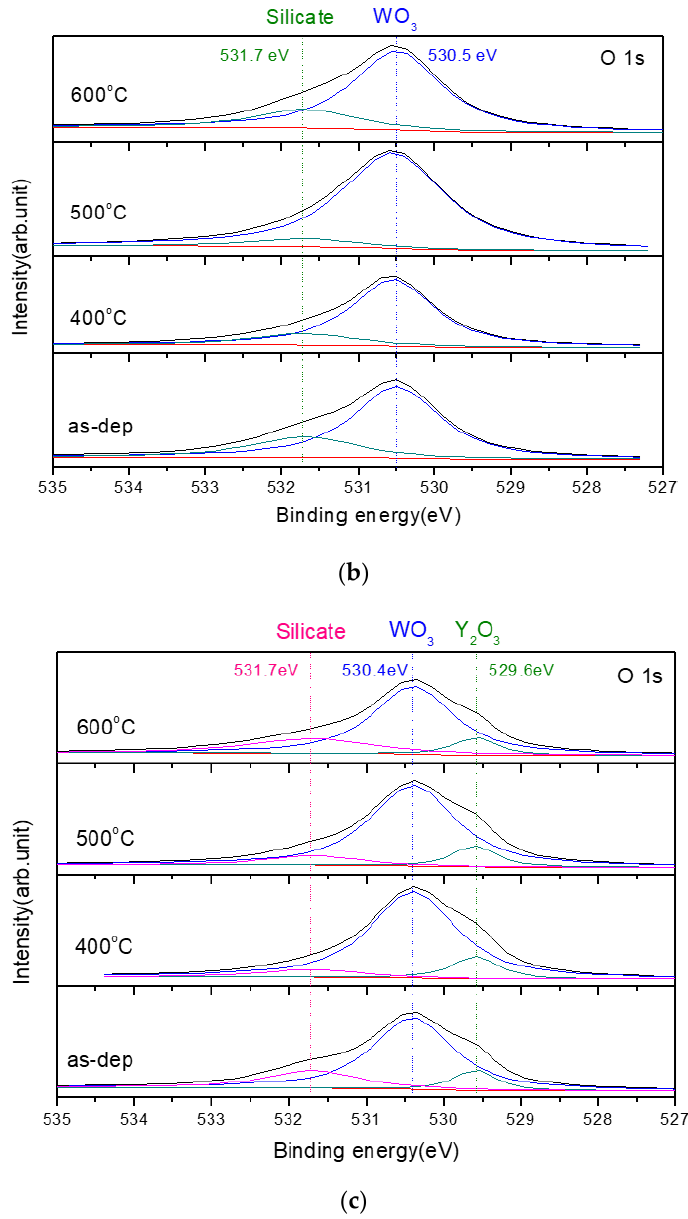
Figure 3. ( a ) The Y 3D XPS spectra of Y-doped WO 3 film annealed at different temperatures in O 2 ambient for 30 s. ( b ) O 1s of WO 3 film. ( c ) O 1s of Y-doped WO 3 , annealed at various temperatures in O 2 ambient for 30 s.